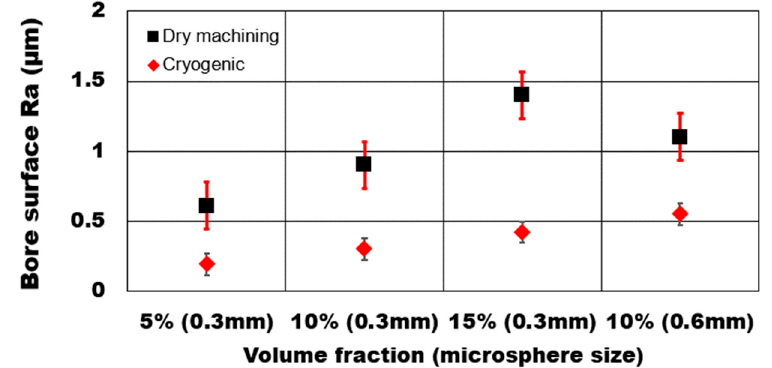
Figure 8. Effect of volume fraction and microsphere size on machined bore surface roughness (Ra) during plunge drilling of AZ31-alumina syntactic foam.